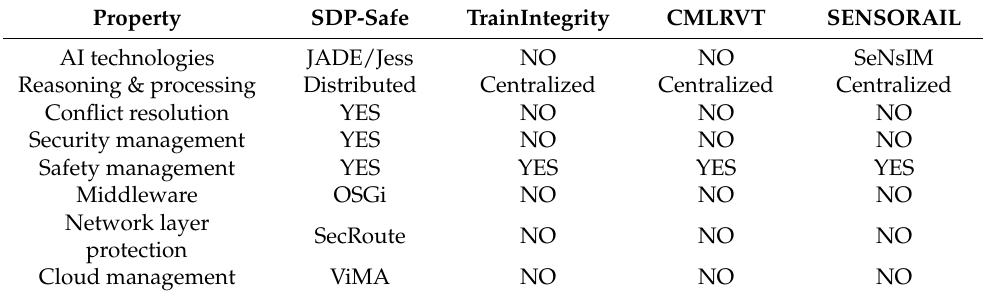
Table 6. Smart railway